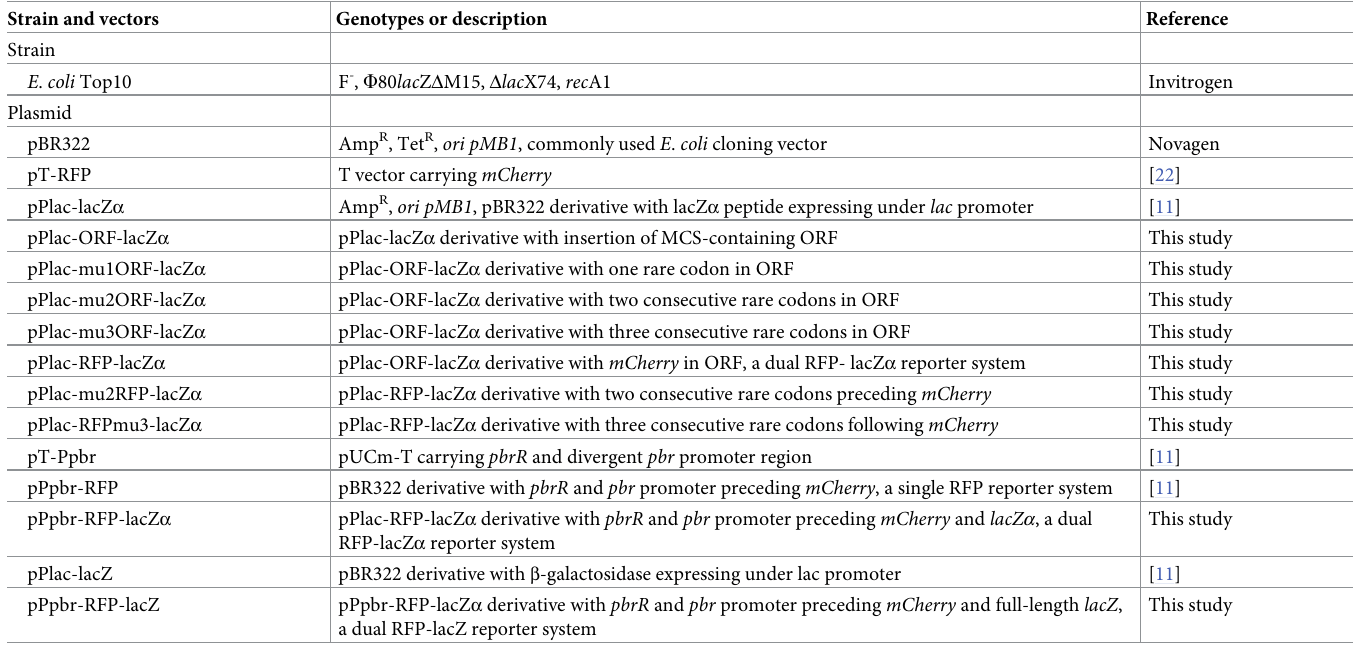
Table 1. Bacterial strain, plasmids, and primers used in this